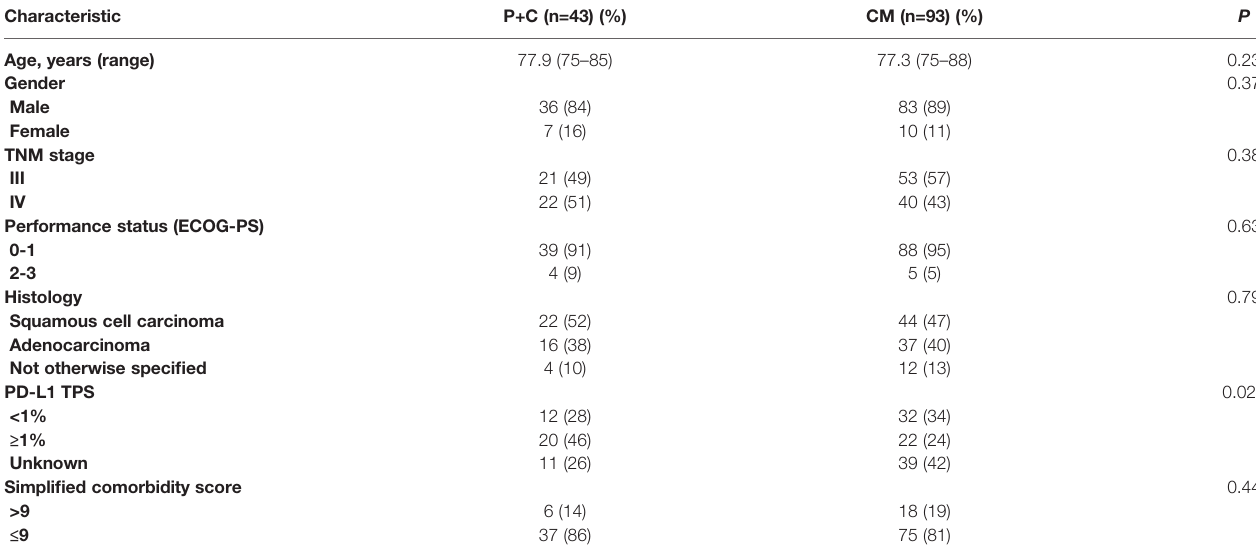
TABLE 1 | Baseline characteristics of patients with different treatments before and after matching.